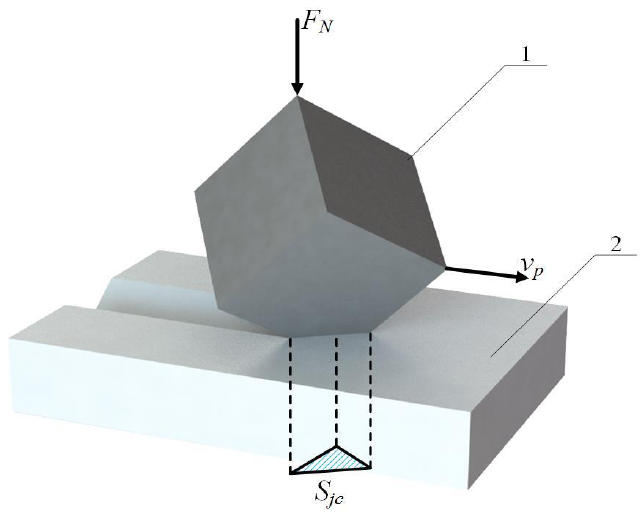
Figure 3. Material removal model of single particle: 1, particle; 2, machined surface.